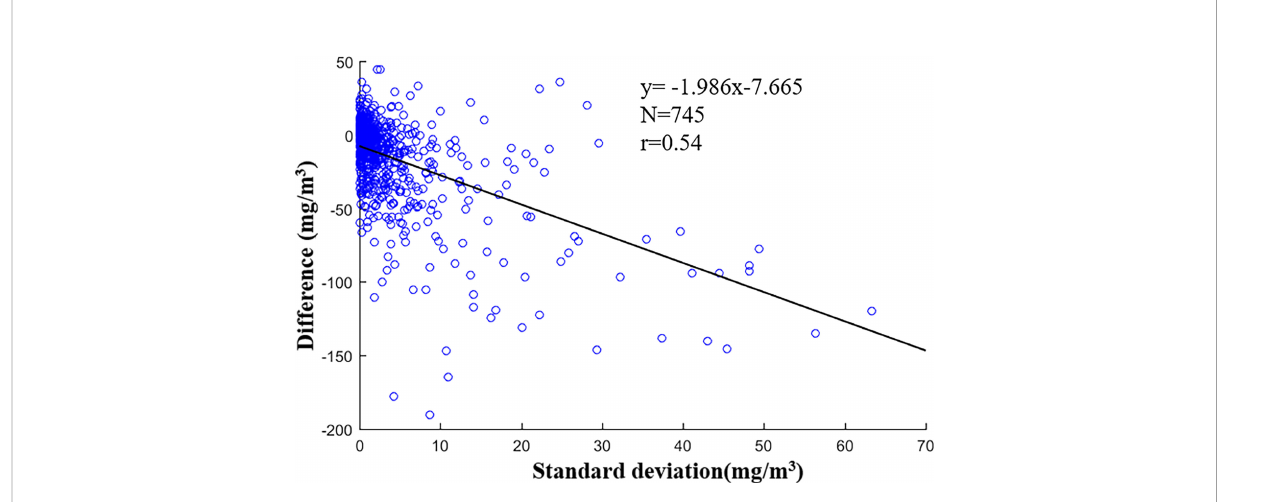
FIGURE 12 Relationships between standard deviation and